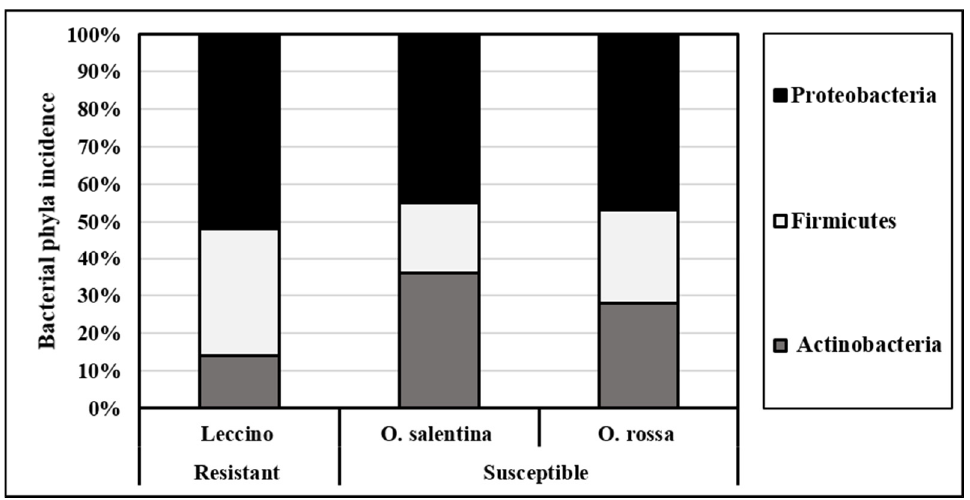
Figure 1. Overall incidence and taxonomic diversity of endophytic bacteria phyla in the sapwood of the studied olive varieties.